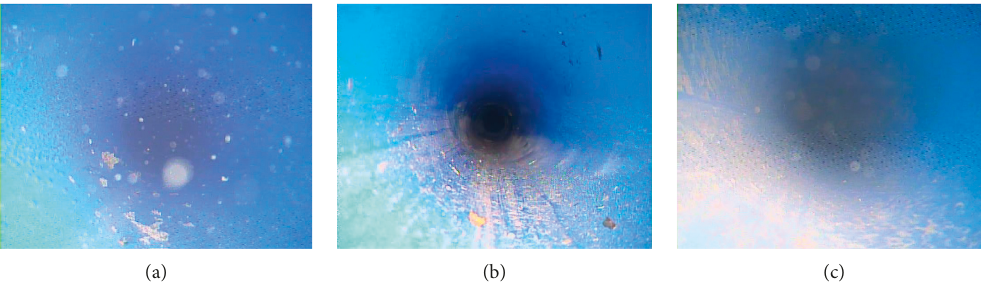
Figure 12: Pipe under electromagnetic field. (a) October 28, 2016. (b) January 28, 2017. (c) April 28,